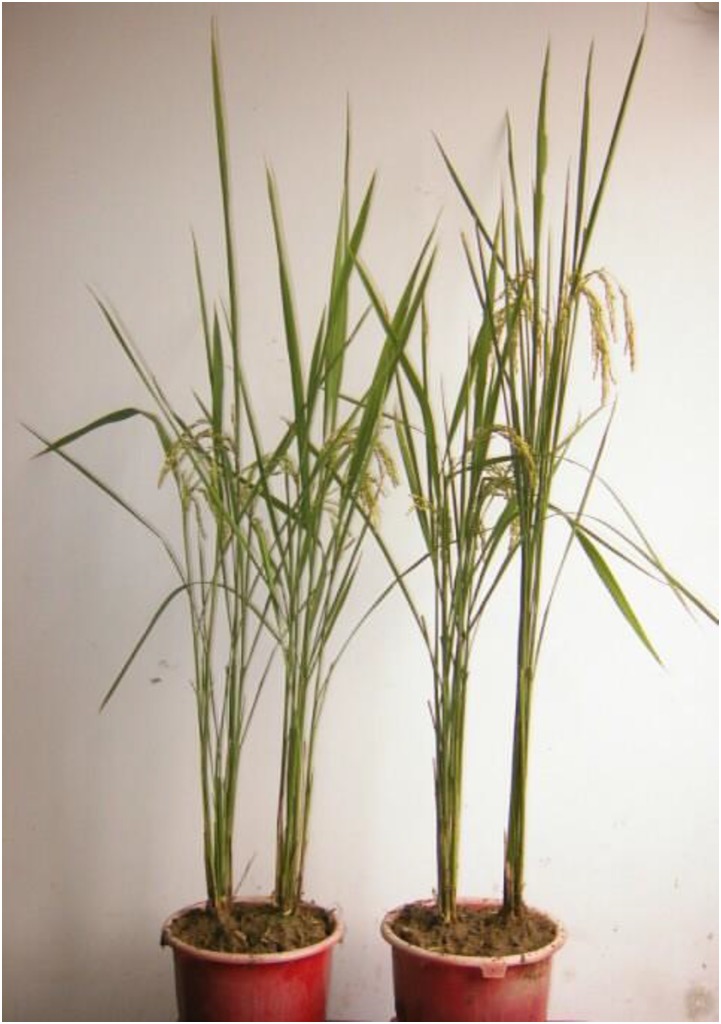
Tall wide type (WT), semidwarf mutant (M), and the F1 progeny derived from reciprocal crosses between M and WT [from right to left: WT, M, (WT/M)F1, (M/WT)F1].